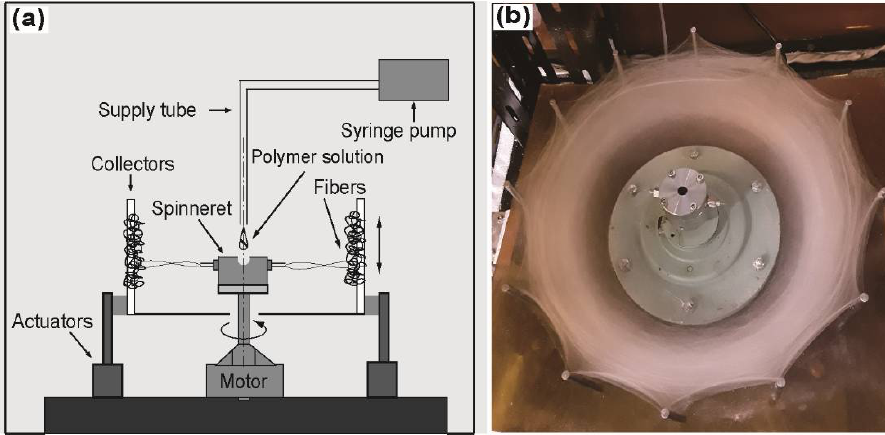
Figure 1. ( a ) Schematic diagram of the CS system used in the present study and ( b ) photograph of an rPET-fiber web produced by